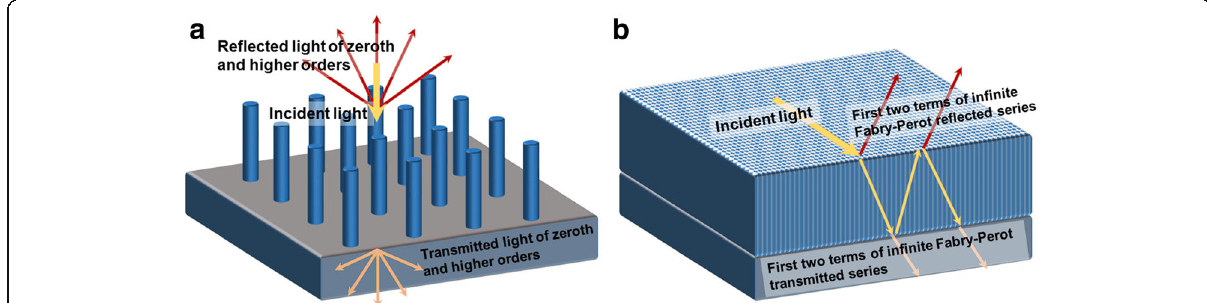
Fig. 2 Light reflection, transmission, and absorption of NWs and effective medium layer. a InP NW arrays and b the corresponding effective medium layer with the same